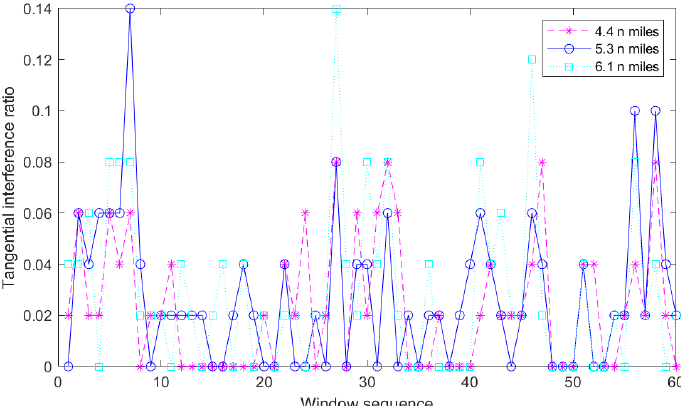
Figure 2. Tangential interference ratio model at 4.4 n miles, 5.3 n miles and 6.1 n miles.